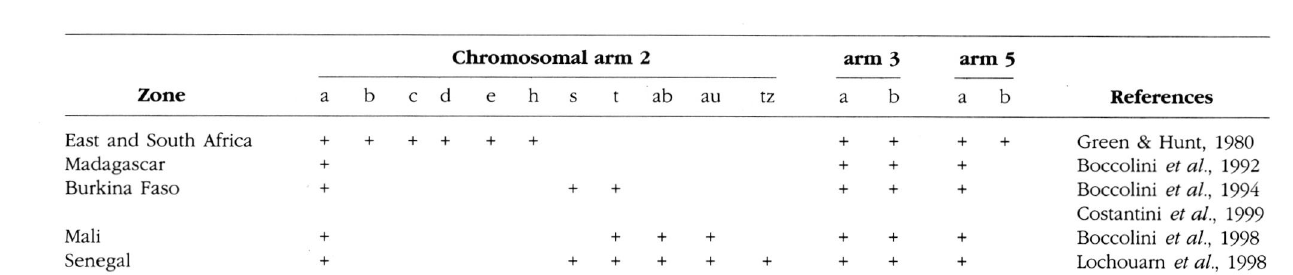
mens analysed so far being homozygotes 3ab/ab.